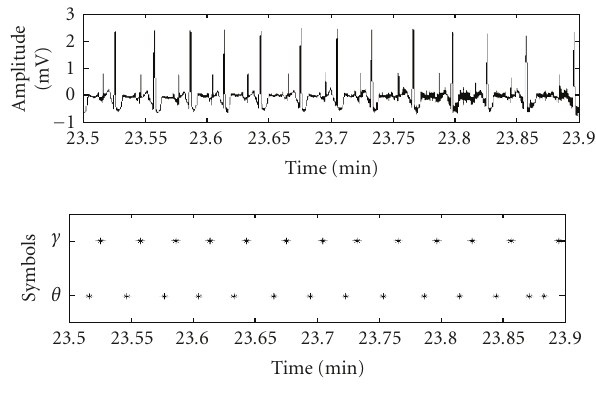
Figure 9: A patient with ventricular bigeminy.